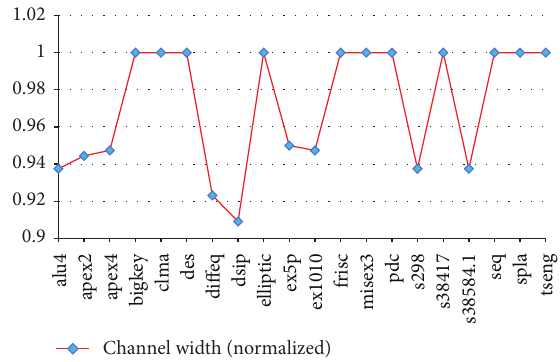
Figure 4: Comparative results of channel width for diffusion based placement algorithm using average approach normalized to the respective results from VPRs placement algorithm for cluster size 𝑁 = 4 .